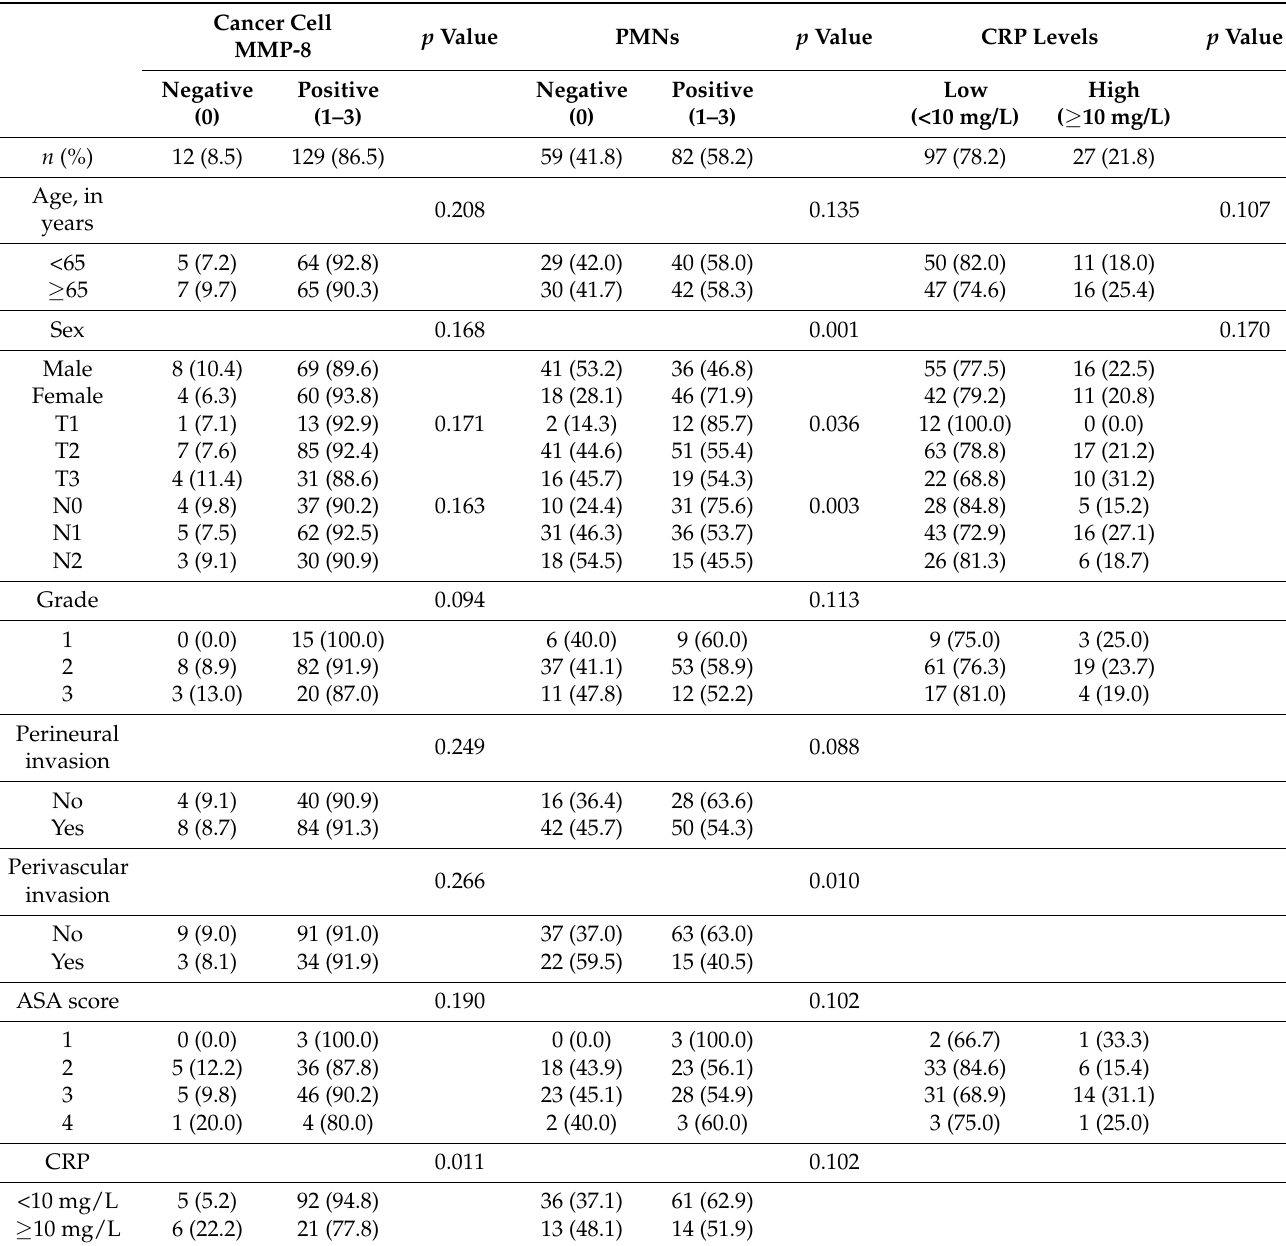
Table 1. Association of cancer cell matrix metalloproteinase 8 (MMP-8) expression in cancer cells, the number of tumour-associated MMP-8 positive polymorphonuclear cells (PMNs) and the plasma C-reactive protein (CRP) level with clinicopathological